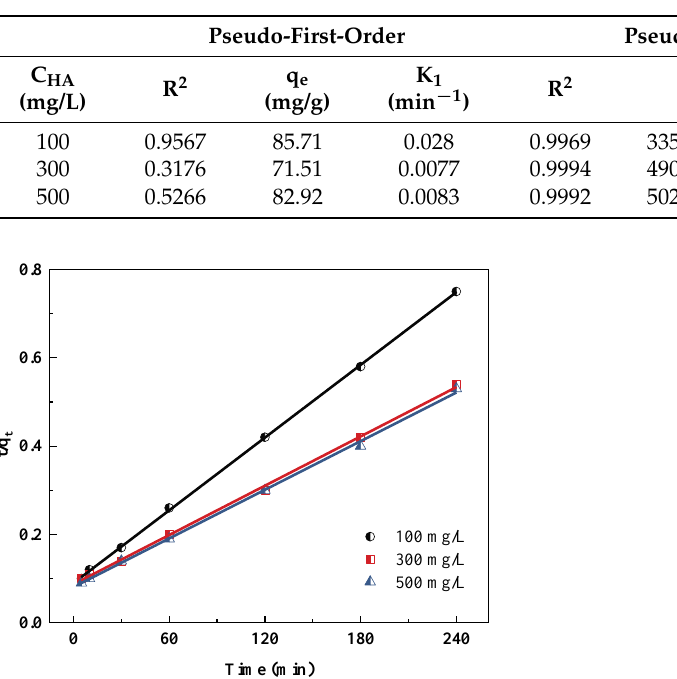
Table 1. Comparison of the pseudo-first-order and pseudo-second-order kinetic models for the adsorption of HA onto RGO-SiO 2 .